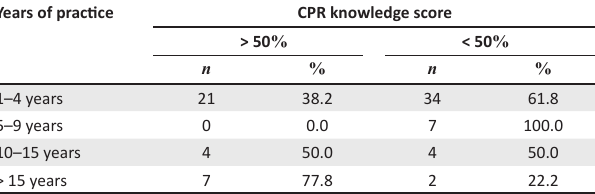
CPR, cardiopulmonary resuscitation. FIGURE 1: Number of correct health worker responses to knowledge items regarding cardiopulmonary resuscitation and anaphylaxis reaction. TABLE 2: Cardiopulmonary resuscitation knowledge scores according to participants’ years of practice ( p =